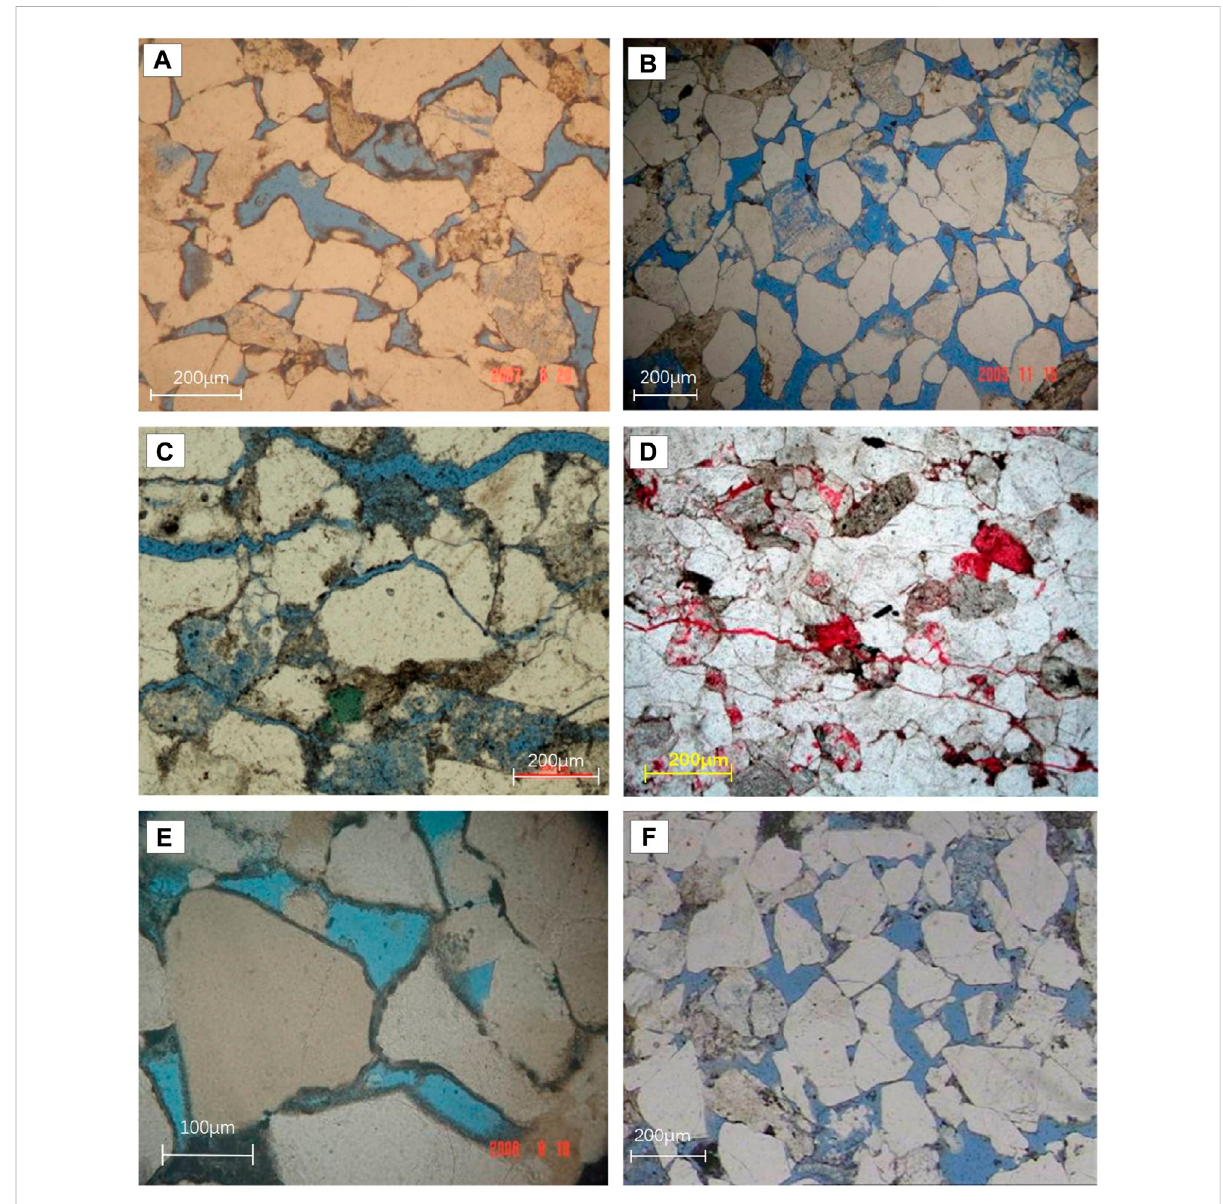
FIGURE 4 Microstructure characteristics of tight sandstones of Xujiahe Formation in the study area. (A) Well Hechuan 7, 2,191.18 m, detrital feldspar sandstone with developed intergranular pores; (B) Well Guang ’ an 101, 2080.15 m, detrital feldspar sandstone; (C) Well Penglai 11, 2,360.54